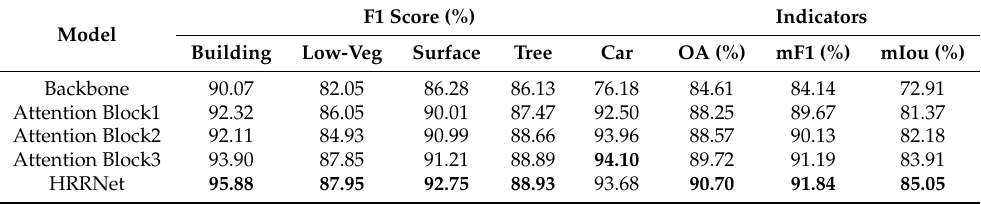
Table 3. Ablation results of the first set (on Potsdam data set), the optimal results are bolded. Model